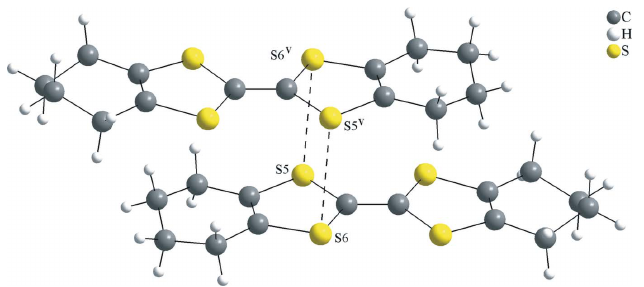
Figure 2 Representation of the centrosymmetric dimer (OMTTF (cid:4) + ) 22+ of the title compound. The S (cid:2)(cid:2)(cid:2) S intermolecular interactions are drawn as dashed lines. Symmetry code: (v) (cid:3) x + 1, (cid:3) y + 1, (cid:3) z + 1.